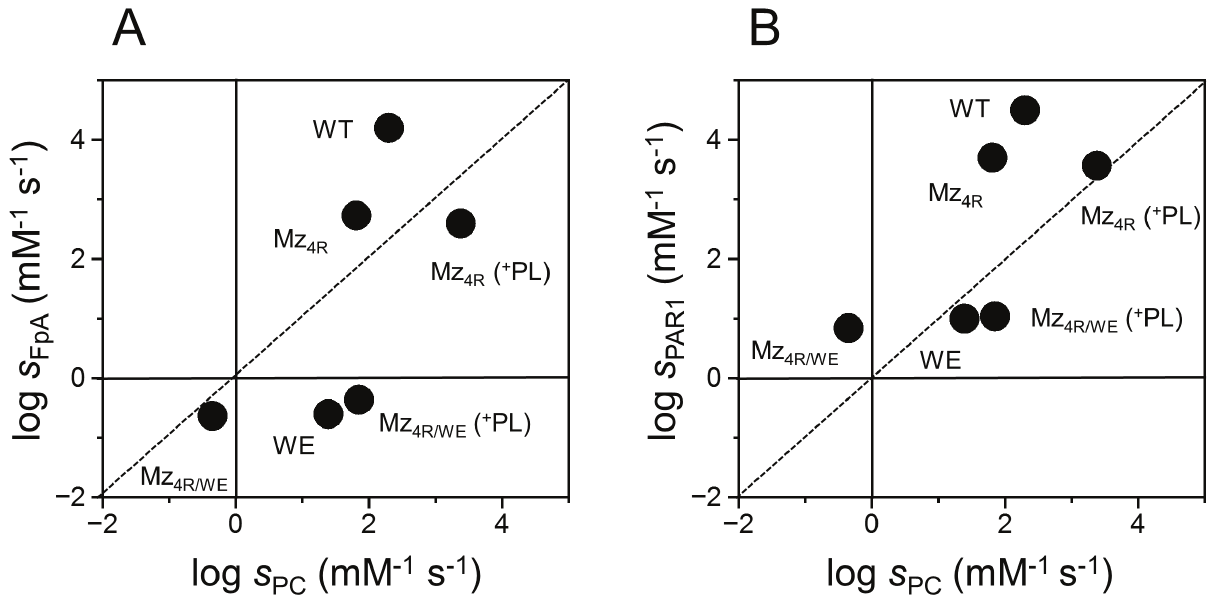
/ K for cleavage of fibrinogen ( s ) (A) or PAR1 ( s ) (B) are Figure 2A-B . Two dimensional plots of Mz and thrombin activities. Values of s = k cat m FpA PAR1 plotted vs those for protein C ( s ) activation. The region below the diagonal dotted line denotes activity toward protein C that exceeds that PC for fibrinogen (A) or PAR1 (B). The reverse is true for the region above the diagonal line. Phospholipids (PL) at a saturating concentration of 0.5 mM (see also Figure 3) selectively enhance the activity of Mz (Mz or Mz ) toward protein C, without affecting the rates of fibrinogen 4R 4R/WE and PAR1 cleavage. The WE mutation profoundly decreases the activity of thrombin (WE) and Mz (Mz ) toward fibrinogen and PAR1. 4R/WE Addition of phospholipids completely restores the activity of Mz toward protein C and produces a significant anticoagulant effect that 4R/WE slightly exceeds that of the thrombin mutant WE. Values for wild-type (WT) and WE (WE) thrombin are from ref.